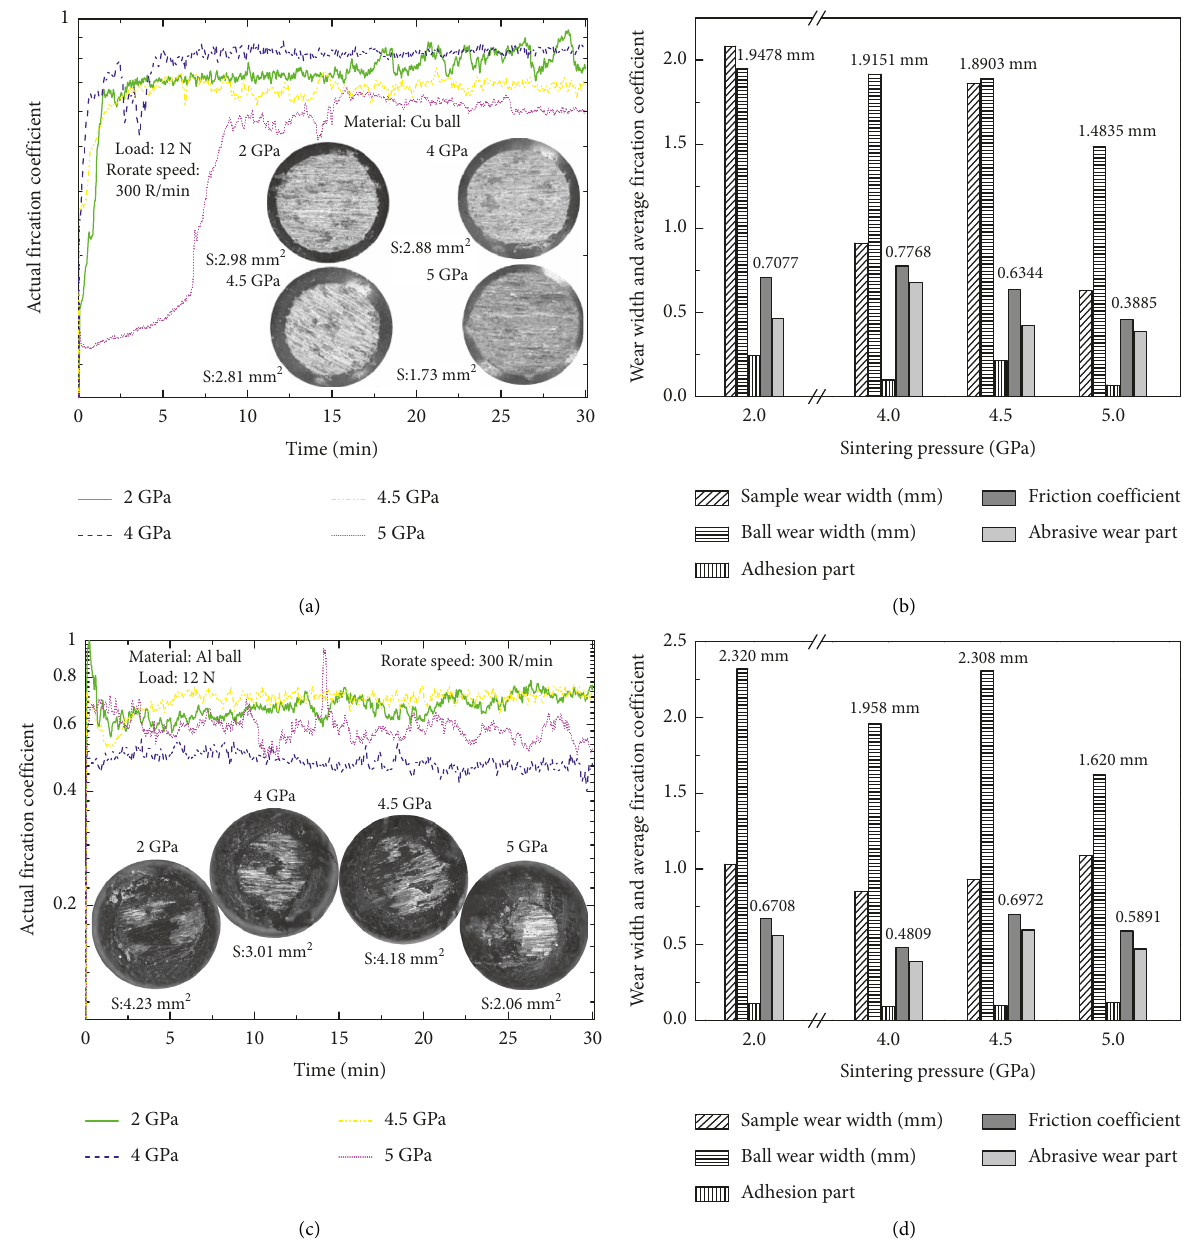
Figure 6: Friction coefficient (a) and wear properties (b) of synthetics and Cu pairs; friction coefficient (c) and wear properties (d) of synthetics and Al